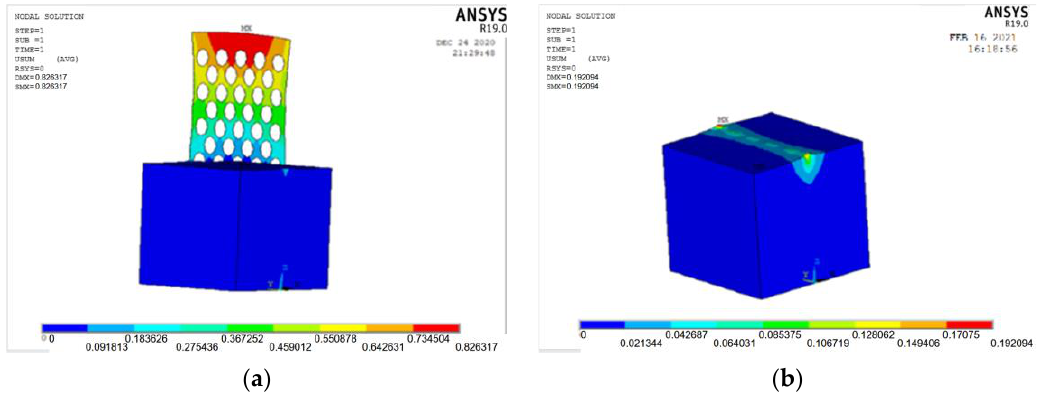
Figure 21. Cloud diagram: ( a ) strain cloud diagram of specimens; ( b ) concrete strain cloud map.